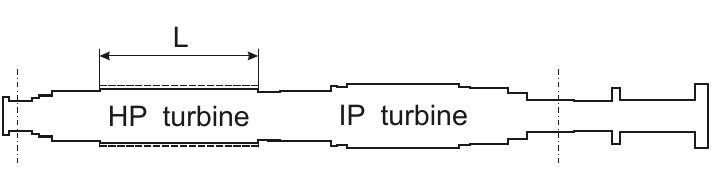
Fig. 22. Sketch of stiffness change on HP